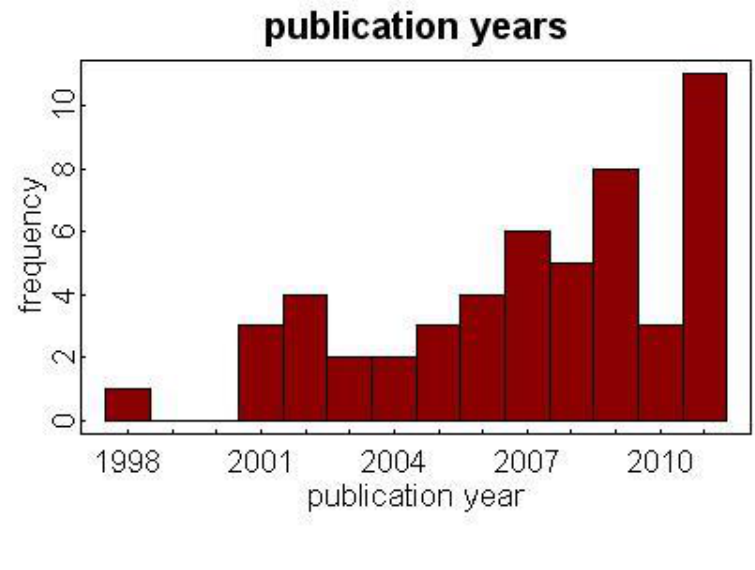
Papers included in review (from